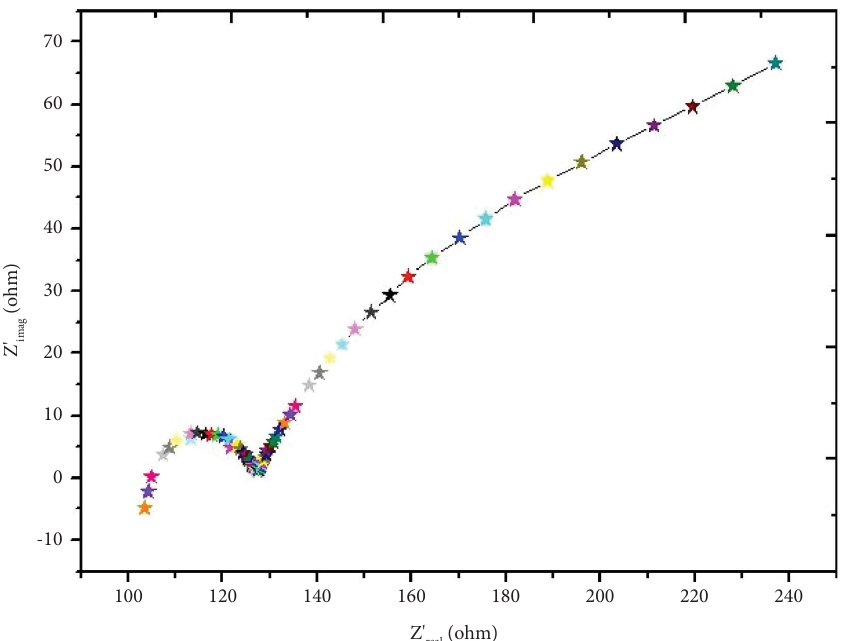
Figure 3: Electrochemical impedance spectroscopy study of the system.